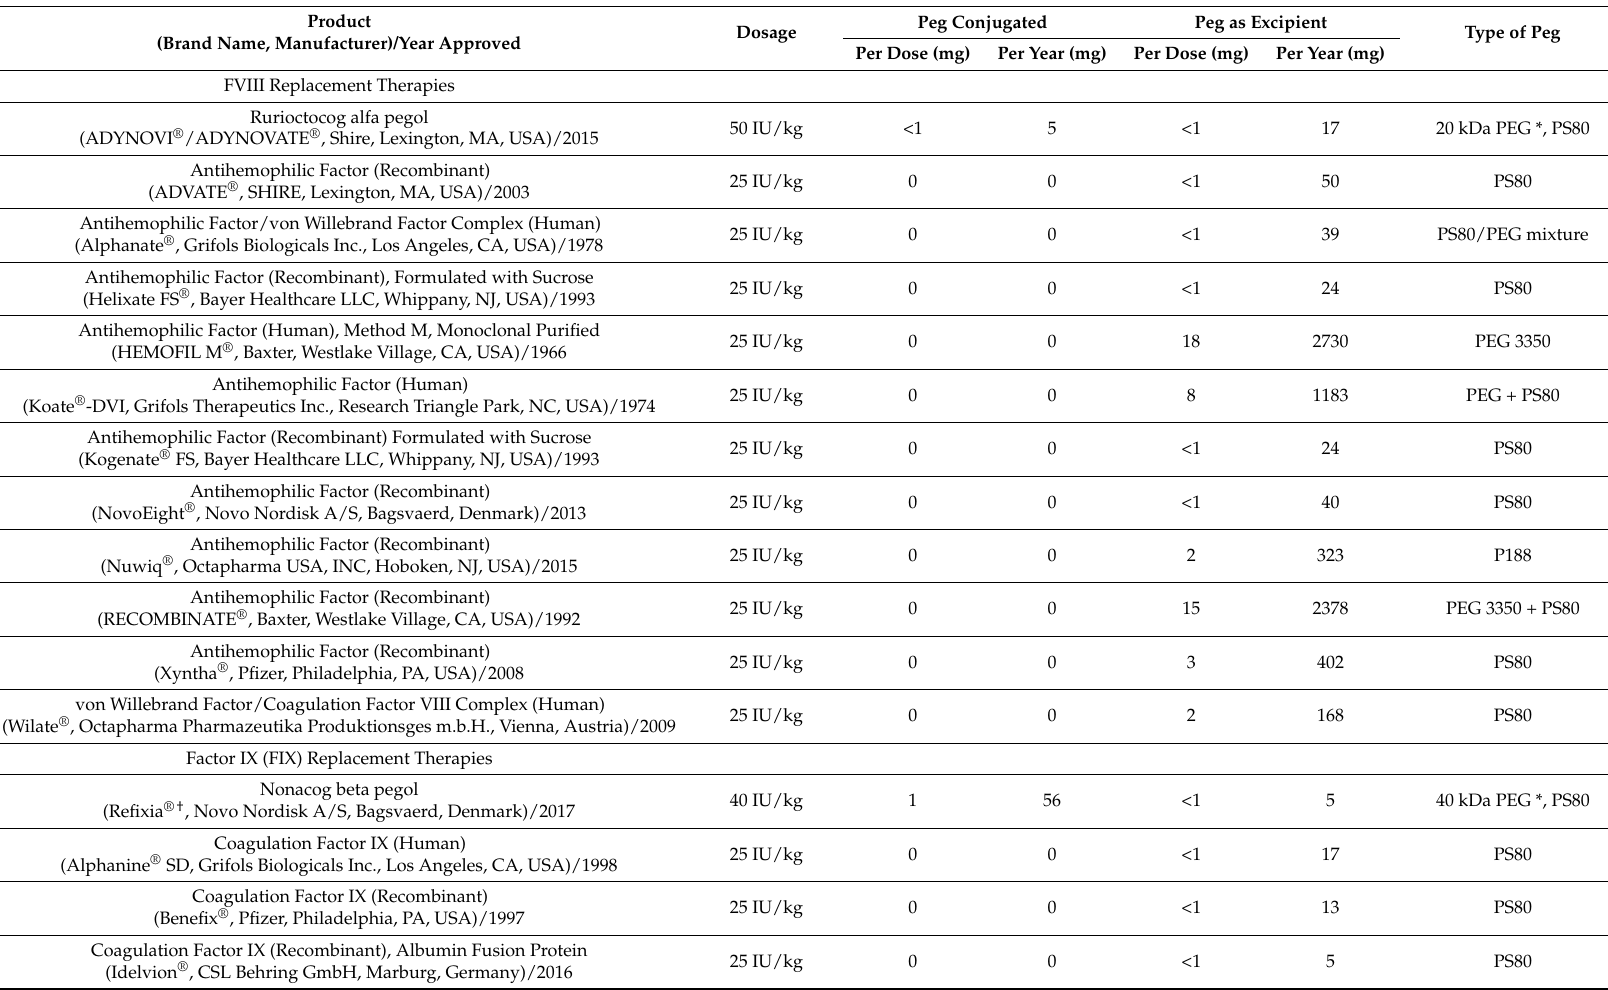
Table 1. Estimated PEG exposure in a 10 kg pediatric patient from the minimal dose indicated from FDA-approved IV or IM therapies with pediatric